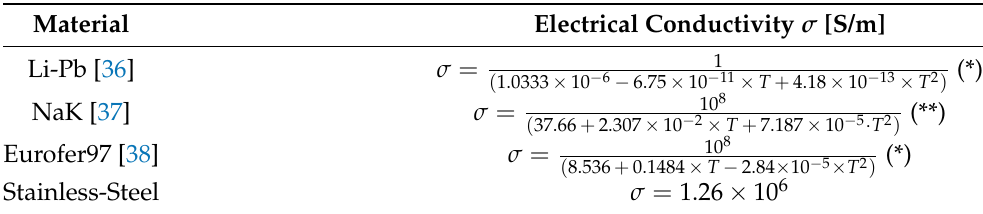
Table 1. Electrical conductivity for different materials. (*) Temperature T in K. (**) Temperature T in